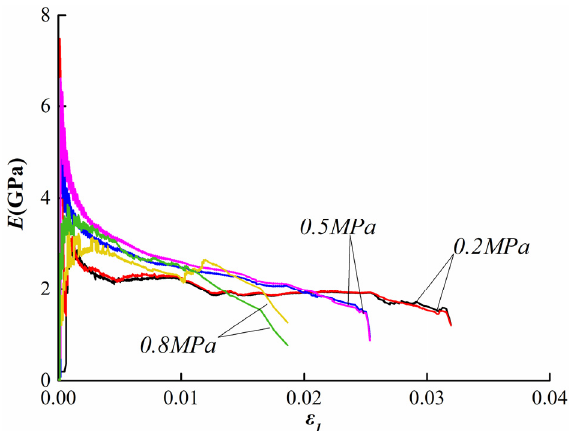
Int. J. Environ. Res. Public Health 2022 , 19 , x FOR PEER REVIEW Figure 6. Deformation modulus curve. Figure 6. Deformation modulus curve.